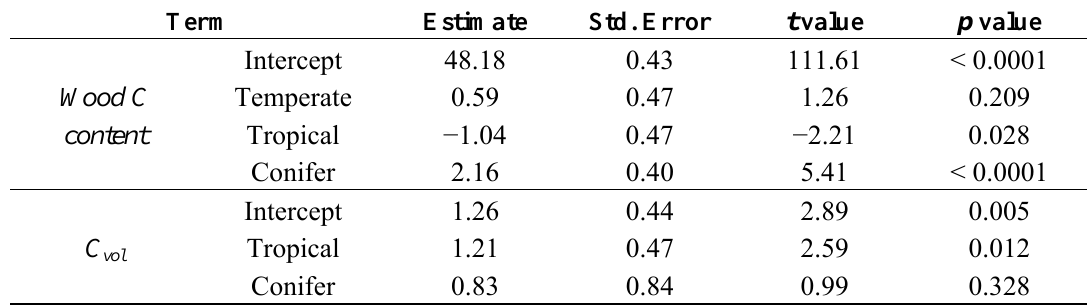
Table 4. Parameter estimates from a generalized least squares regression predicting wood ) as a function of biome and C and the volatile C fraction (C vol